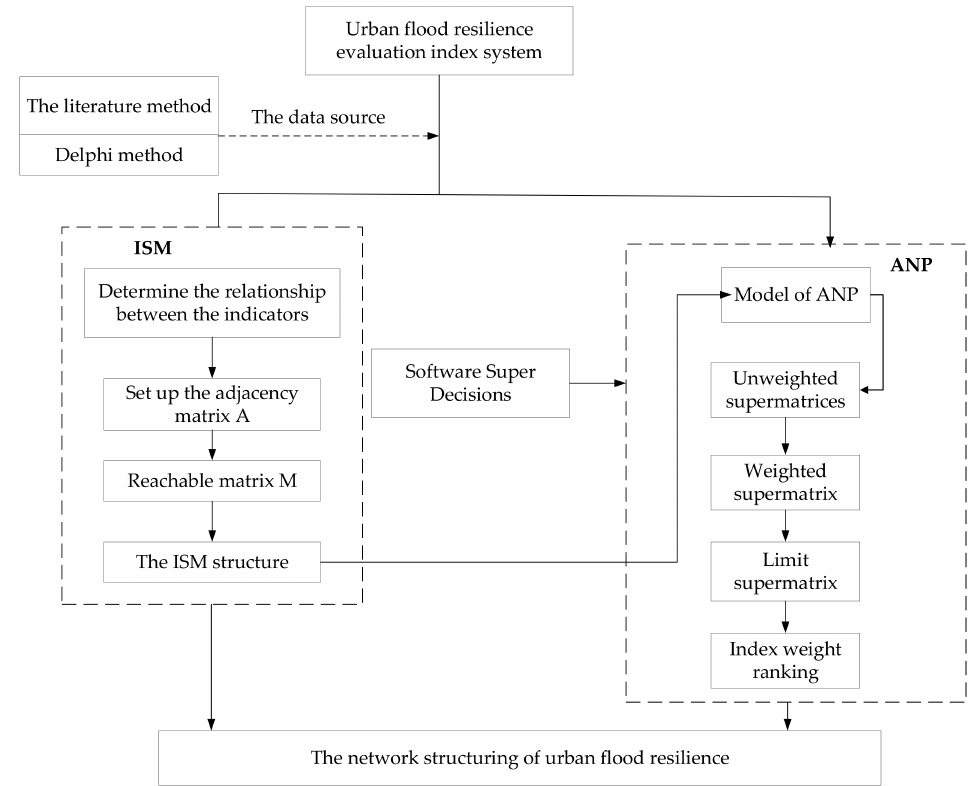
Figure 2. Framework of resilience indicators analysis with a network structuring